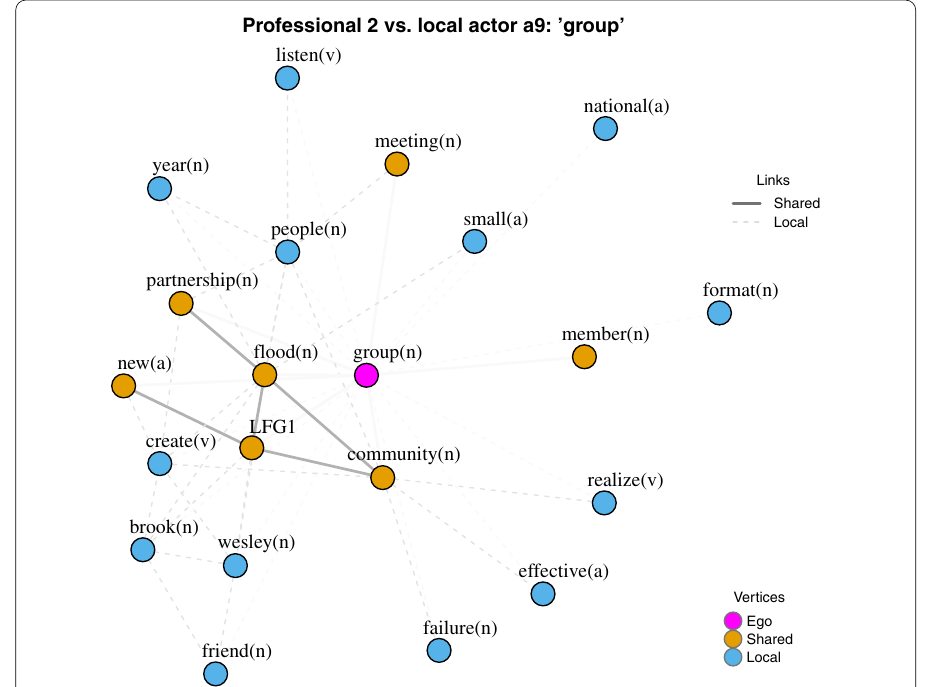
Fig. 7 The professional network is based on threshold value 2. For display purposes, only shared and local-specific concepts are